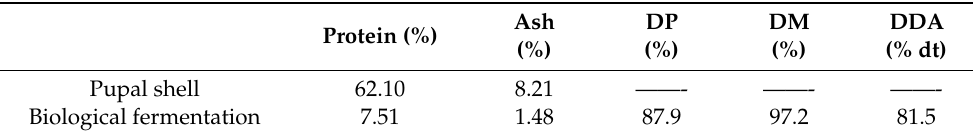
Table 1. Extraction of chitin from BSF spent pupal shell.